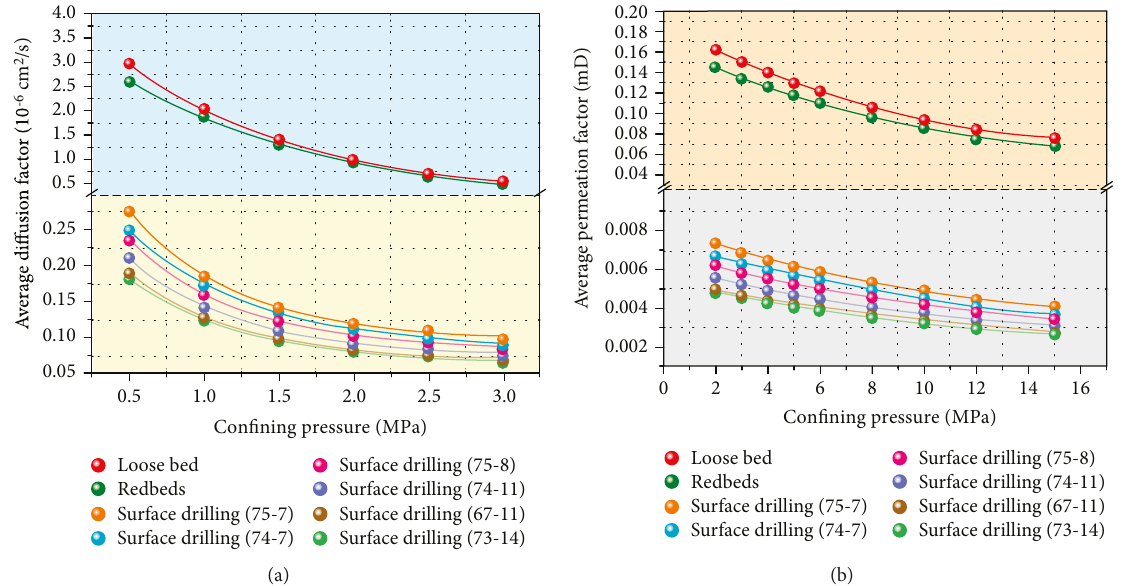
Figure 13: Changes of average di ff usion and permeation factors of loose bed, Redbed, and surface drilling holes (coal-bearing strata). Note: loose bed refers to Quaternary and Neogene rocks; Redbed refers to Paleogene